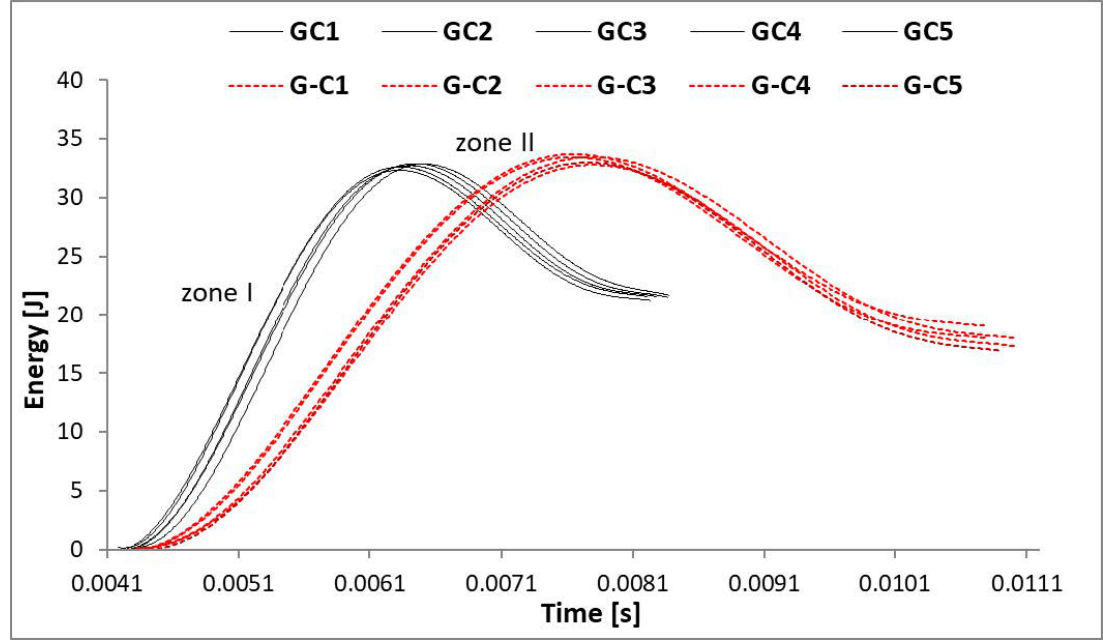
Figure 3. Energy – time curves of the tested hybrid under low-velocity impact tests. Figure 3. Energy–time curves of the tested hybrid under low-velocity impact